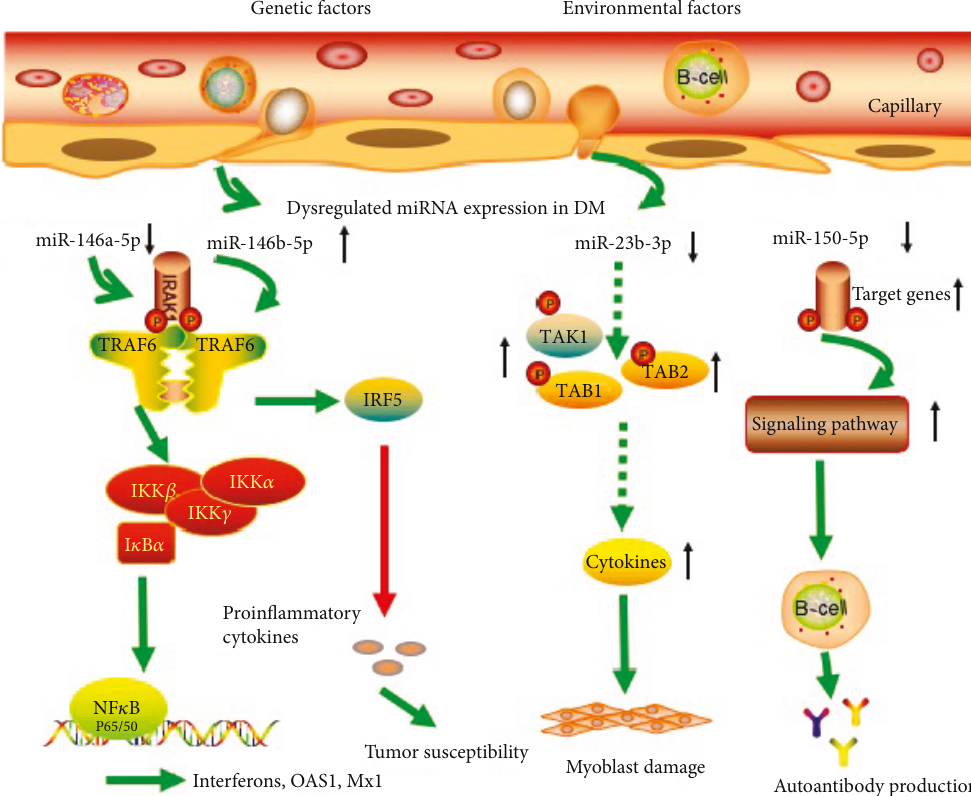
Figure 5: Schematic diagram of the regulation role of four immune-related miRNAs in DM. IRAK1: interleukin-1 receptor-associated kinase 1; TRAF6: tumor necrosis factor receptor-associated factors 6; IKK α : inhibitor kappa B kinase α ; IKK β : inhibitor kappa B kinase β ; IKK γ : inhibitor kappa B kinase γ ; IkB α : inhibitor k binding α ; IRF6: interferon regulatory factor 6; NF- κ B: nuclear factor-k-gene binding; TAK1: TAB2: transforming growth factor-beta-activated protein kinase 1-binding protein 1; TAK1: transforming growth factor- β -activated kinase 1. Table 3: Serum/plasma expression of miRNAs correlated with clinical phenotypes in DM.